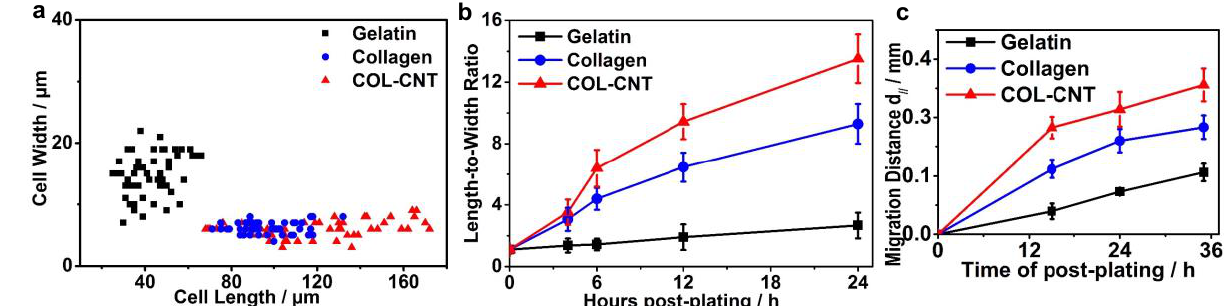
Figure 2. Examination of cell polarization and migration. ( a ) Scatter plot illustrating the correlation between the cell width and cell length of individual cells. The data were derived from more than 50 cells on each matrix type. ( b ) Change in the length-to-width ratio with time for cells cultured on the matrices. ( c ) Cell migration, characterized by the change in cell migration distance with time, on the matrices by the wound-healing assay.